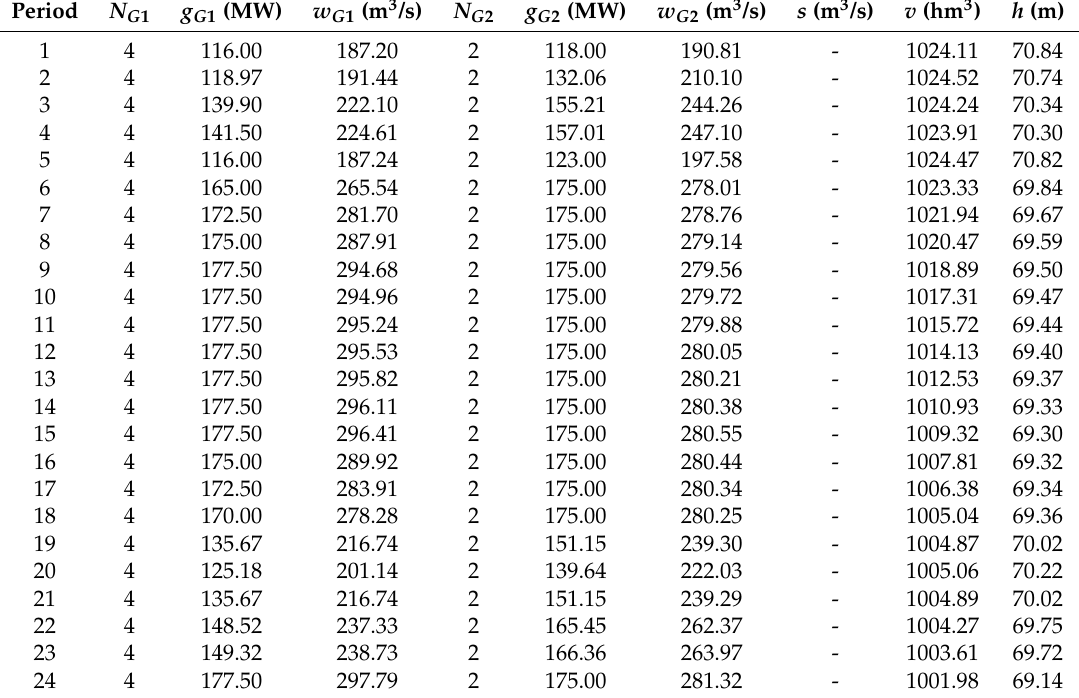
Table 9. Results with power losses-based objective function and null spillage upper bound-scenario